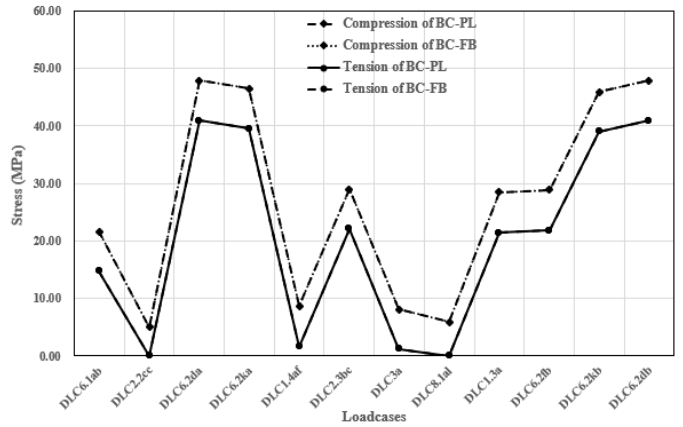
Figure 8. Comparison of stresses in shaft of piled model (BC-PL) and fixed model (BC-FB).